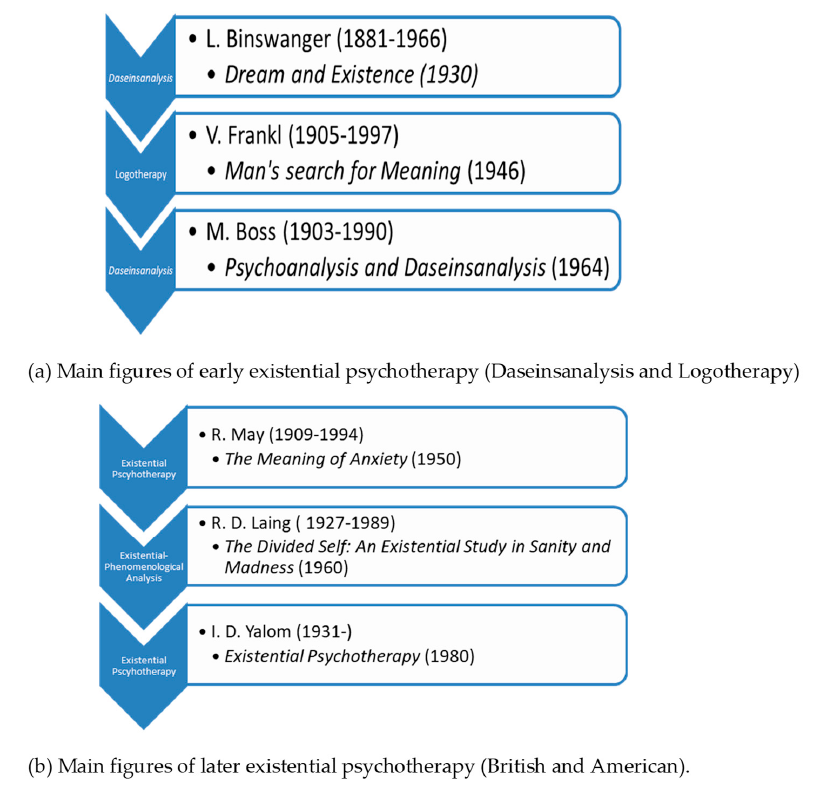
Figure 3. Main figures of early existential psychotherapy and later existential psychotherapy. ( a ) Main figures of early existential psychotherapy (Daseinsanalysis and Logotherapy). ( b ) Main figures of later existential psychotherapy (British and American).